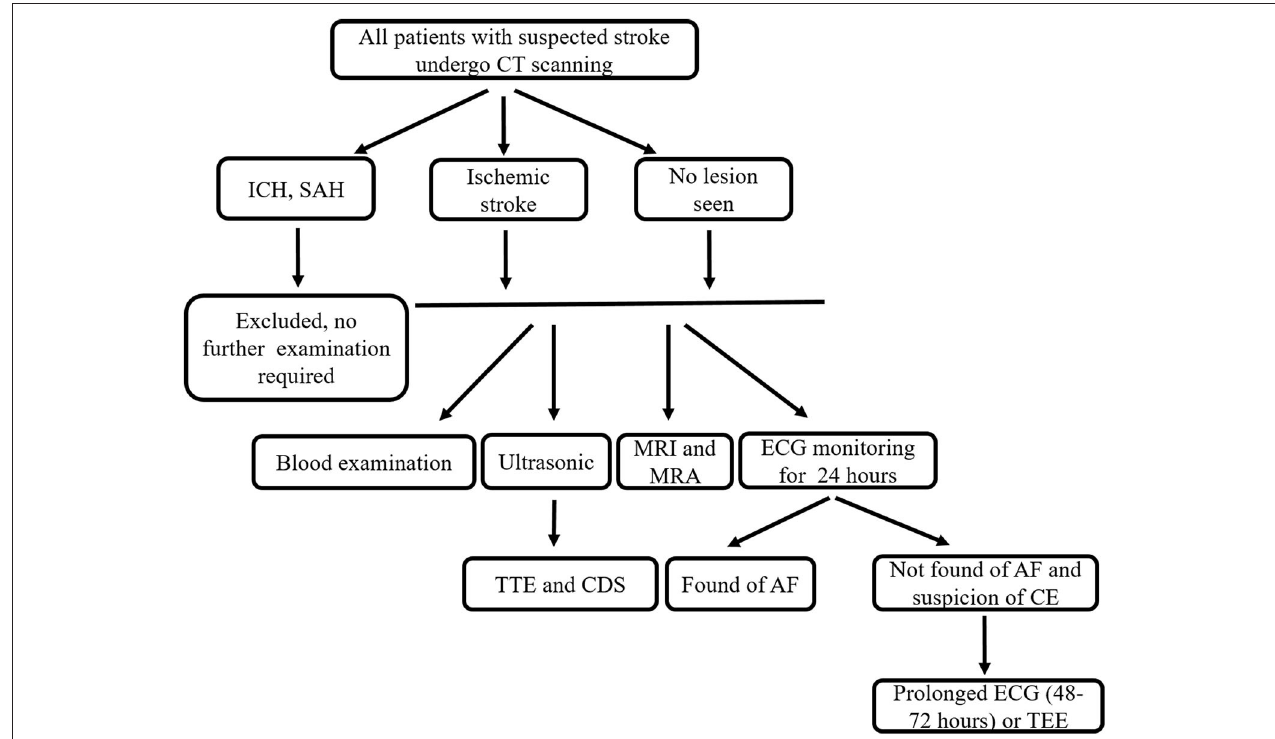
FIGURE 1 | Examination flow chart. CT, computer tomography; ICH, intracerebral hemorrhage; SAH, subarachnoid hemorrhage; MRI, magnetic resonance imaging; MRA, magnetic resonance angiography; ECG, electrocardiogram; TTE, transthoracic echocardiography; CDS, carotid duplex sonography; AF, atrial fibrillation; CE, cardioembolism; TEE, transesophageal